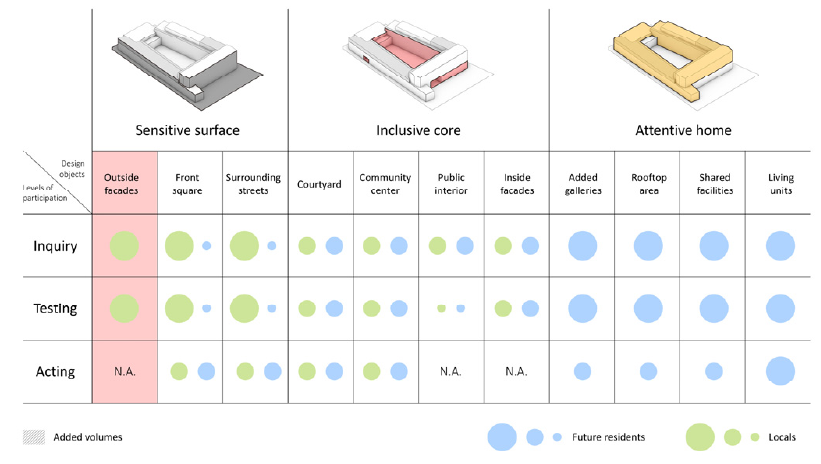
Figure 2. Applying three levels of participation to the case study.